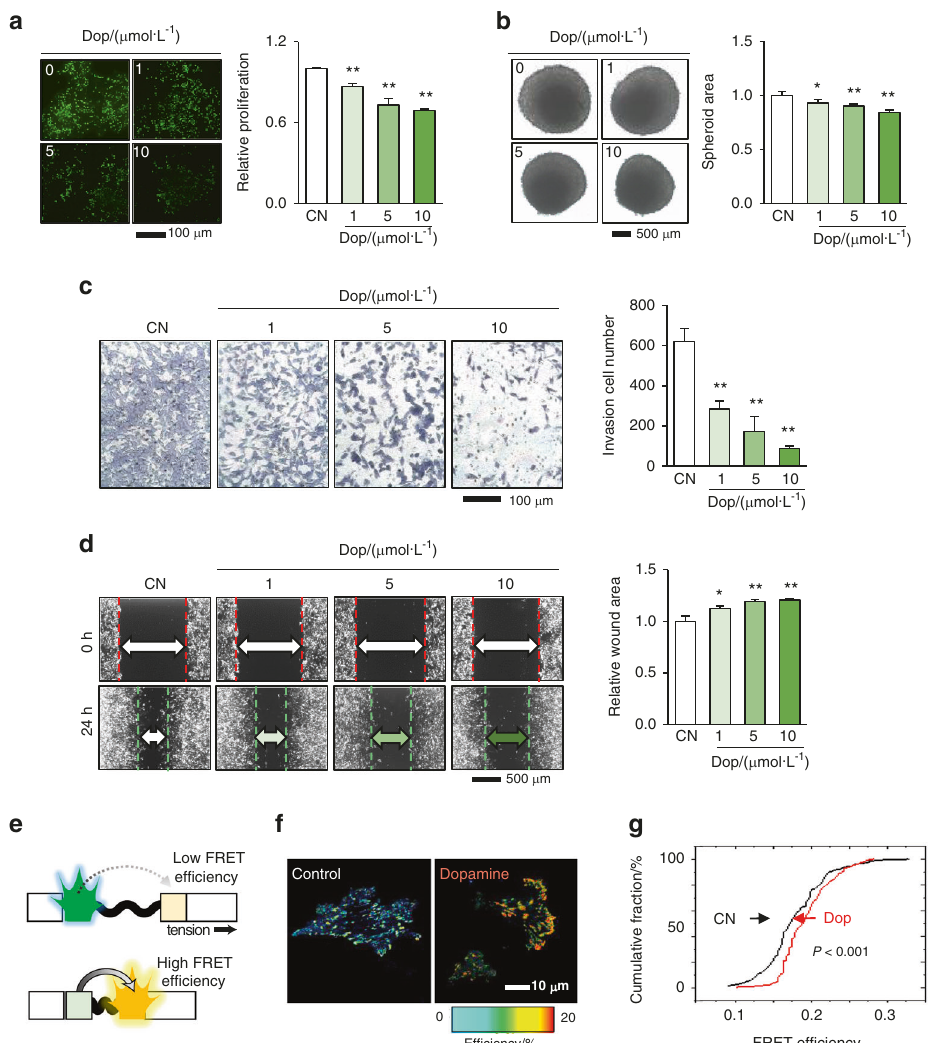
Fig. 2 Inhibitory effects of dopamine in the proliferation, invasion, and migration of 4T1Br tumor cells. CN control, Dop dopamine. The single and double asterisks indicate P < 0.05 and 0.01, respectively. a , b Reduction in EdU-measured proliferation and the size of tumor spheroids upon exposure to dopamine. c , d Reduction in invasion determined by the Transwell assay and migration determined by the scratch assay after dopamine treatment. e FRET-based measurement of molecular forces. A FRET tension sensor is designed to increase FRET ef fi ciency when the applied molecular force is reduced. f , g Dopamine-induced reduction in molecular forces with an increase in FRET ef fi EO771 cells showed a lower expression level of DRD1 than the three other cell lines (Supplementary Fig. 5a – d), and they presented weaker responsiveness to dopamine (Supplementary Fig. 5e – g). In summary, the result is consistent with the primary role of DRD1 in the dopamine response. A high level of CCN4 transcripts is linked to poor prognosis To further understand the role of CCN4, we employed the Gene